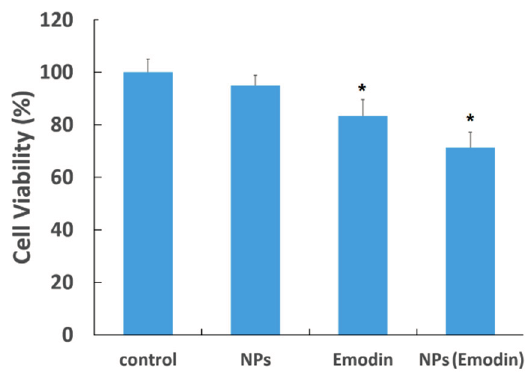
Figure 7. Viability of HUVECs incubated with emodin and emodin–MgSiO 3 . ( * p <